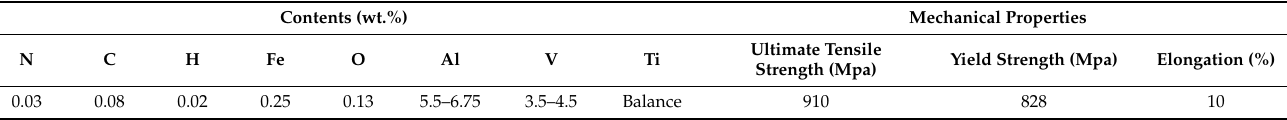
Table 1. Mechanical properties and chemical composition of Ti-6Al-4V ELI.